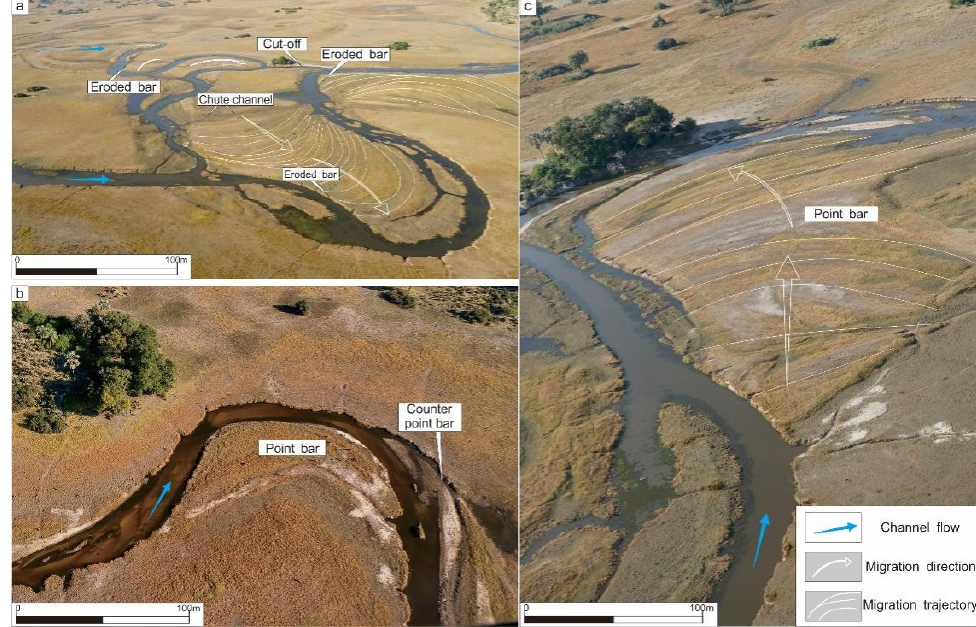
Figure 11. The river of the Okavango meandering river fan shows the geomorphic features of the meandering river. ( a ) Meandering with cut-off, eroded bars and chute channel; ( b ) Meandering with point bar and counter point bar; ( c ) Meandering with compound point bar.